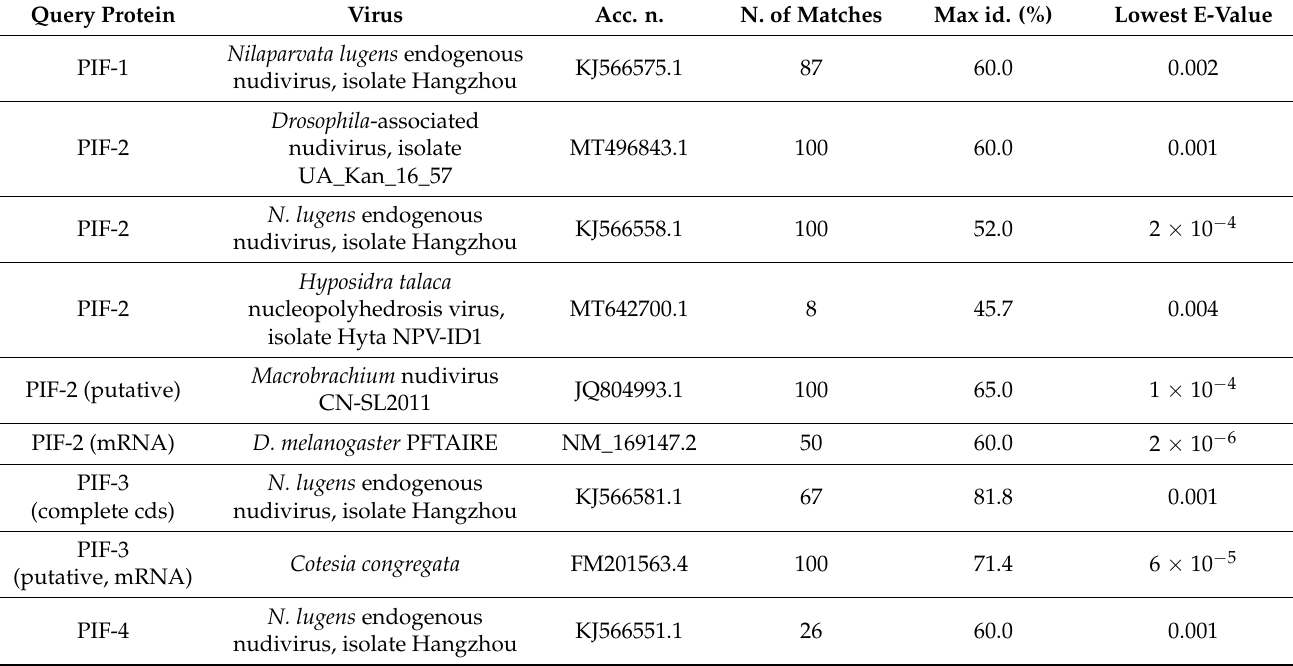
Table 2. Top matches 1 of translated nudivirus PIF proteins, from different arthropod hosts, on the P. spumarius genome 2